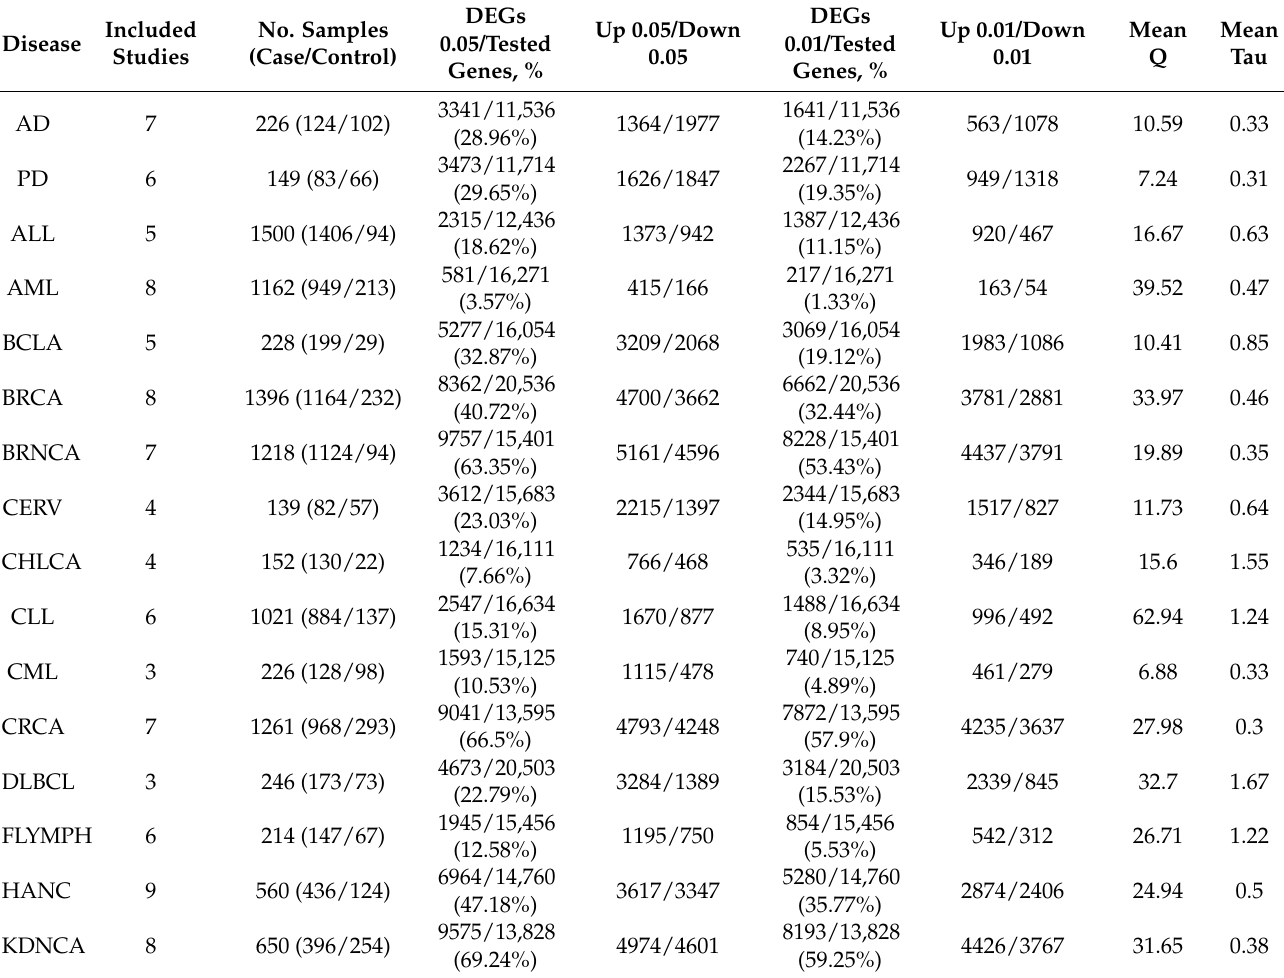
Table 1. Number of differentially expressed genes found in each